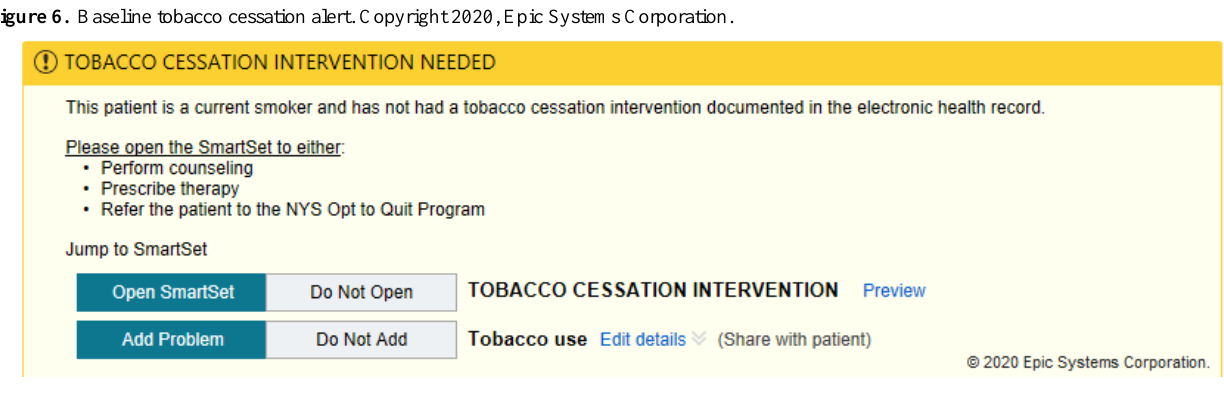
Figure 7. Tobacco financial messaging alert with images tested in Round 2 of the randomized controlled trial. Copyright 2020, Epic Systems Corporation.